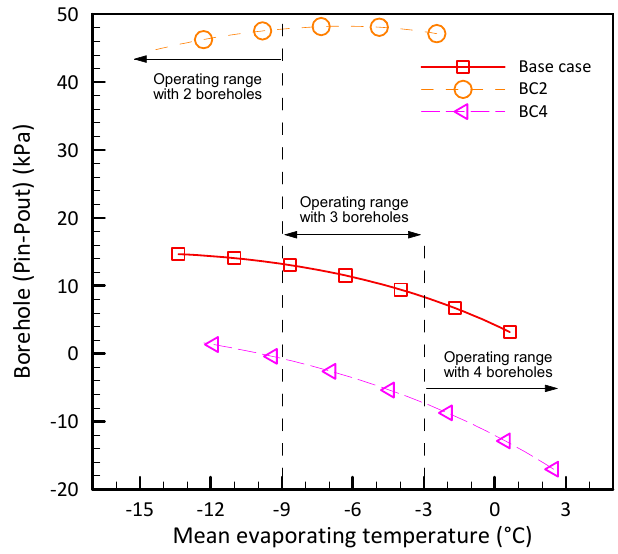
Figure 14. Pressure change in the ground heat exchanger (P in ‐ P out ) .